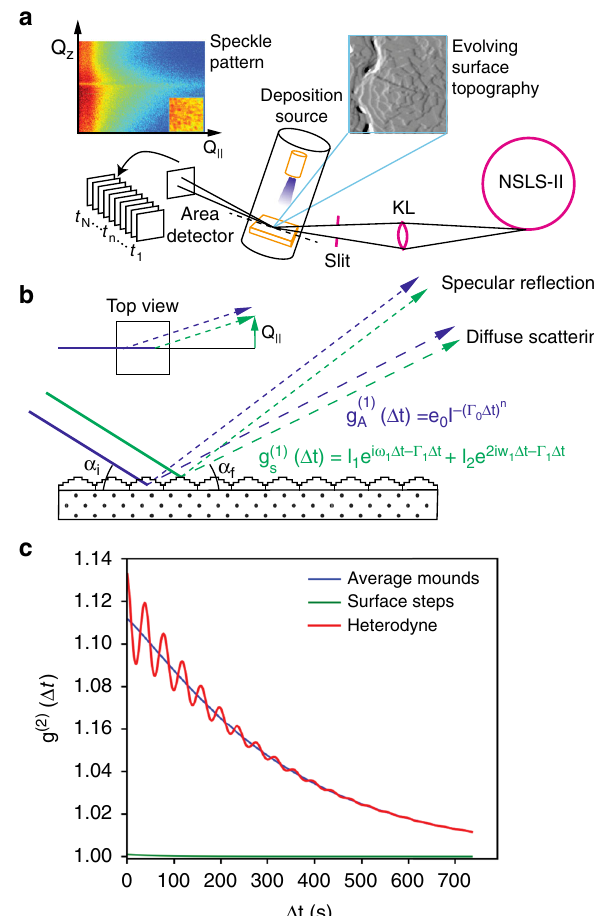
Fig. 1 Schematic of the experiment and coherent mixing effects during C 60 thin fi lm deposition. a X-rays from the synchrotron source are focused by a kinoform lens (KL) and a collimating slit system into an ultra-high vacuum sample enclosure. A polycrystalline thin fi lm is deposited, which causes (111)-oriented crystalline mounds to form via nucleation at the top of each mound and local step- fl ow towards the mound edges. Scattered coherent X-rays form speckle patterns that correspond to the detailed con fi guration of the surface and are recorded versus time by a high-resolution photon sensitive X-ray area detector. b In addition to scattering from the surface (green lines and equation), the X-rays scatter from the average mounds structure (blue). The functions g A (1) ( Δ t ) and g S (1) ( Δ t ) correspond to the intermediate scattering functions for the average and surface mound contributions respectively. c The two signals interfere coherently, creating temporal correlations in the speckle pattern that can oscillate with the frequency ω 1 , which is directly related to the step-edge velocity. This effect occurs even when the averaged intensity is nearly static. The second-order correlation function g (2) ( Δ t ) is extracted from intensity data, as described in the main